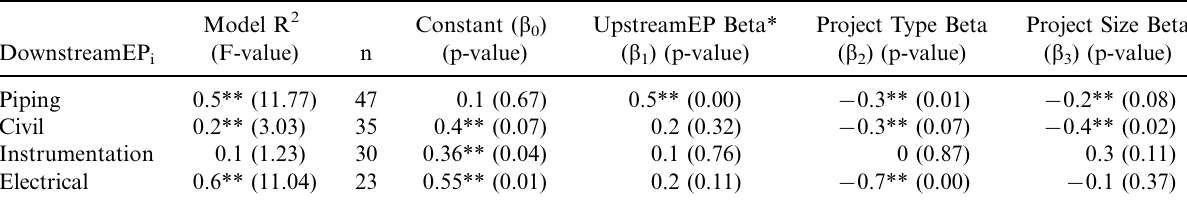
Table 2. Regression models of information dependencies